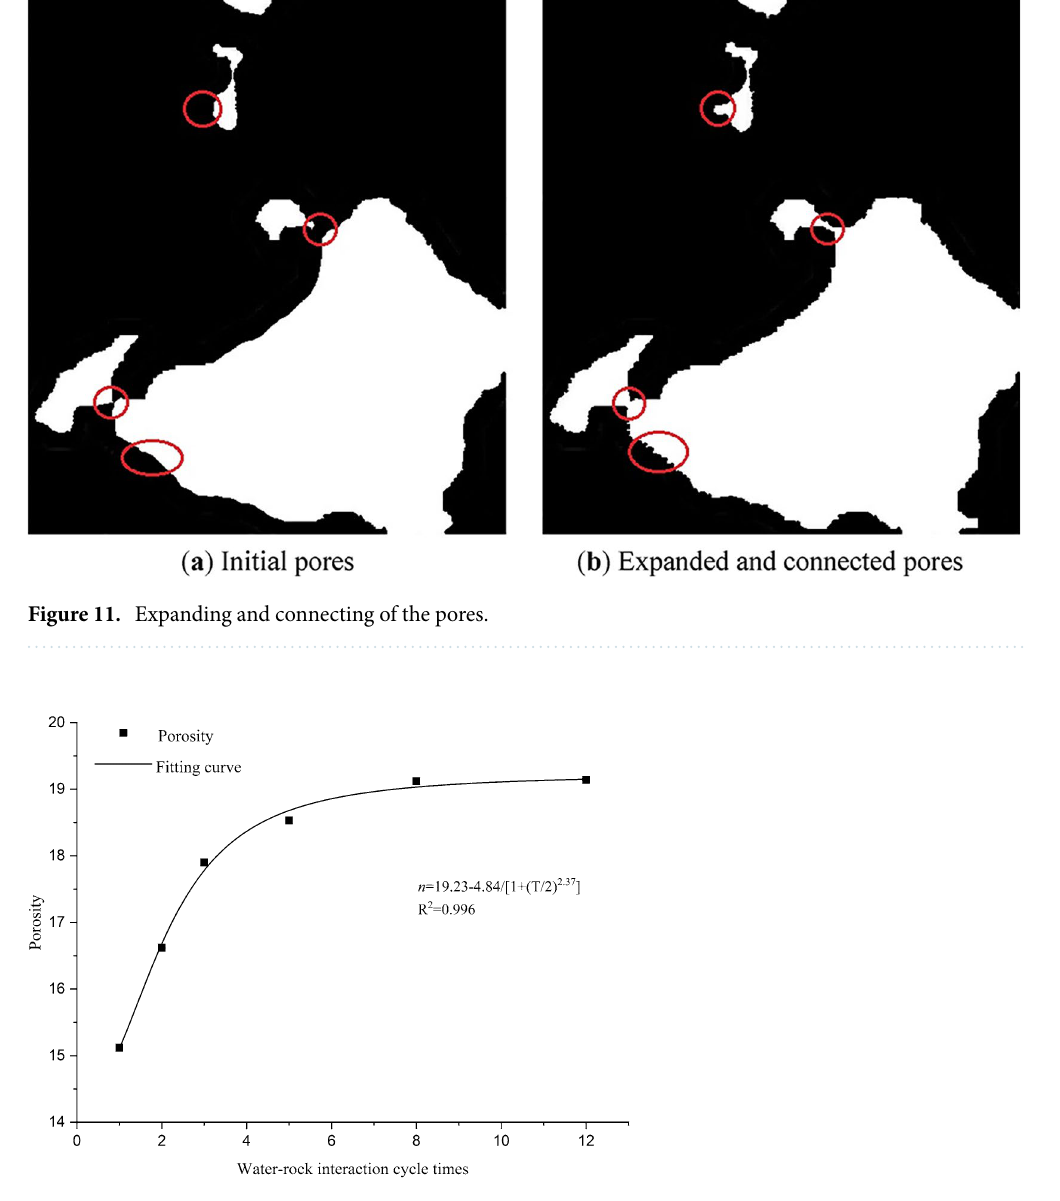
Figure 12. Porosity fitting curve of red-bed soft